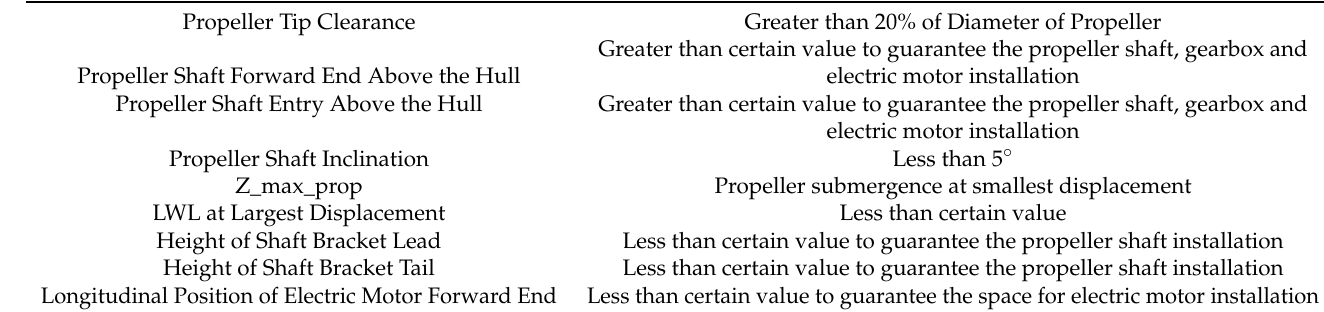
Figure 3. Side view of the geometry of parametric model for transom stern optimization. Table 2. Design constraints defined for the local optimization.